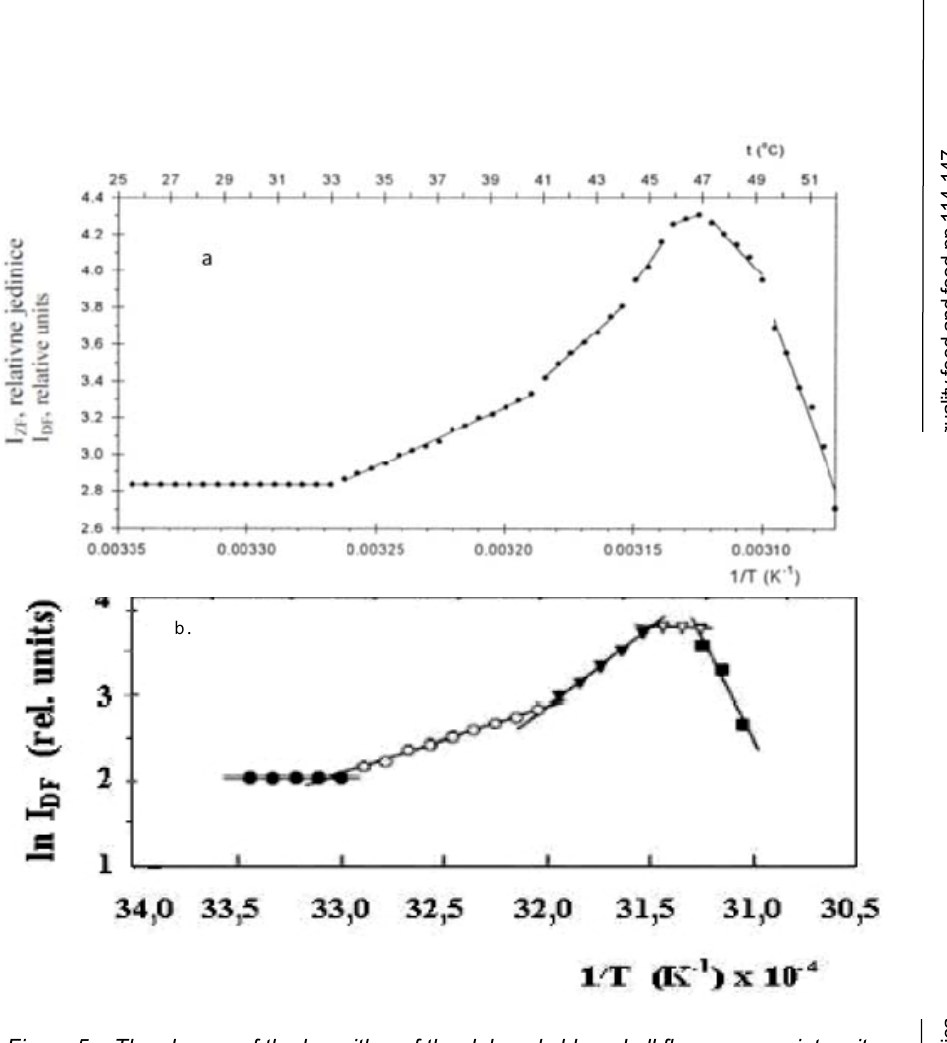
Figure 5 – The change of the logarithm of the delayed chlorophyll fluorescence intensity (ln I DF ) of the thermal processes as a function of the reciprocal temperature value in the thylakoid membrane and chloroplasts of the intact above-ear leaf of the observed air dried maize inbred lines ZPPL 146 (a) and ZPPL 159